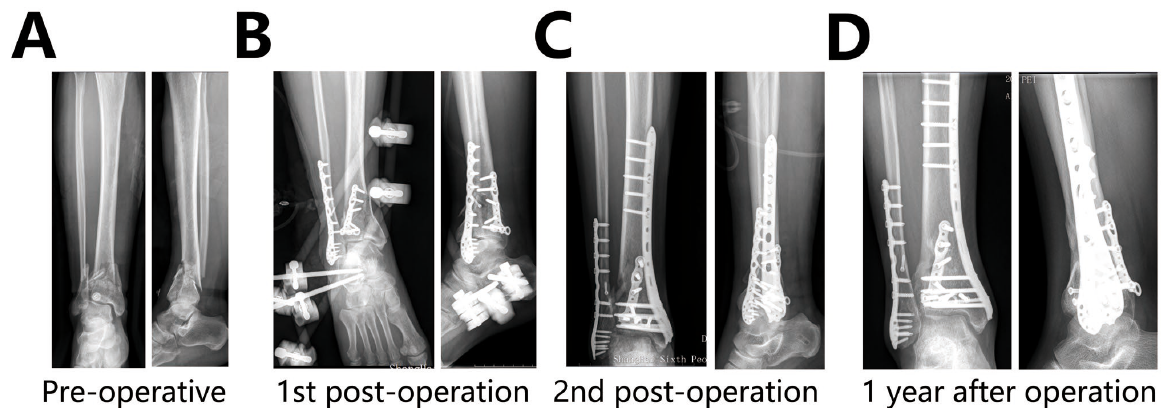
Figure 3. ( A ) Pre-operative X-ray. ( B ) The x-rays show the fixation of the posterior tibial column and fibula by a locking plate in the first surgery, combined with external fixator. ( C ) The x-ray shows the fixation of the tibia with a medial locking plate during the second surgery. ( D ) The x-ray shows the healing of the patient’s fracture one year after surgery.